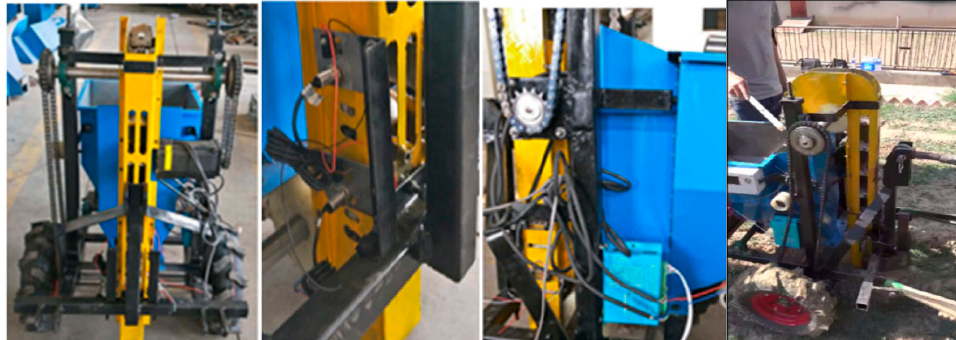
Figure 23. Integrated seeding and compensating potato planter based on one-way clutch. Reprinted with permission from ref. [96]. Copyright 2019 Gansu Agricultural University.